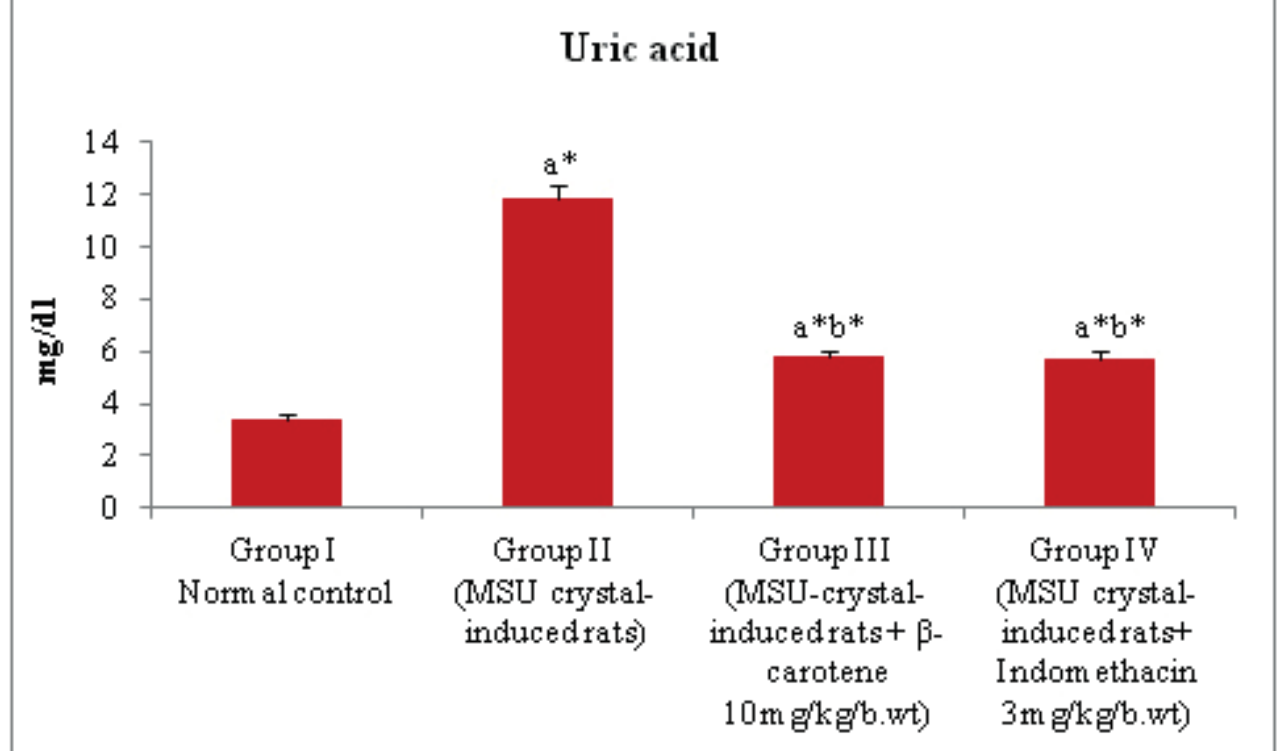
FIGURE 3 - Effect of β -carotene on serum uric acid in MSU crystal-induced arthritis N=6 animals in each group. The values are expressed as mean ± S.D. Comparisons indicated by lower case letters were made as follows: a – group I vs. group II, III and IV; b – group II vs. group III and IV; c – group III vs. group IV. Statistical analysis was carried out by one way ANOVA followed by Student’s Newman – Kuel’s test. The symbols represent statistical significance at: * p <